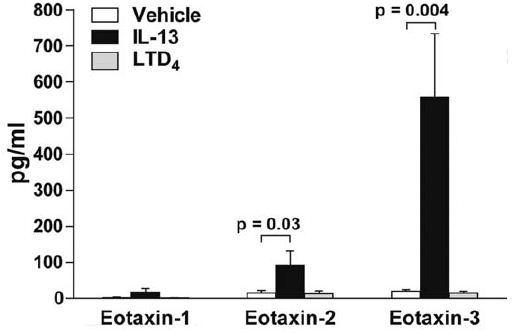
Figure 1. Effect of IL-13 on the release of eotaxins from airway epithelial cells. Airway epithelial cells were treated with vehicle (open bars), 10 ng/ml IL-13 (closed bars), or 100 nM LTD 4 (gray bars) for 24 hours. Incubations were stopped by removing the supernatants and eotaxin-1, eotaxin-2, and eotaxin-3 were quantified as described in Material and Methods . The data represent the mean ( 6 SEM) of four independent experiments.